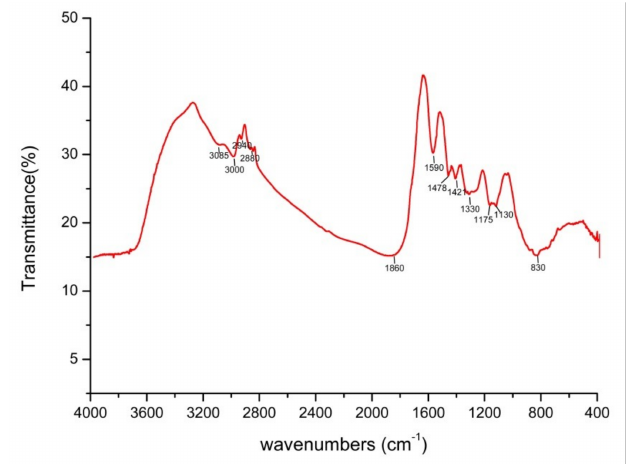
Figure 7. The FTIR spectrum of Bio-SeNPs registered in the 4000–400 cm − 1 infrared regions. with the corrected Figure 7 (Figure 1):